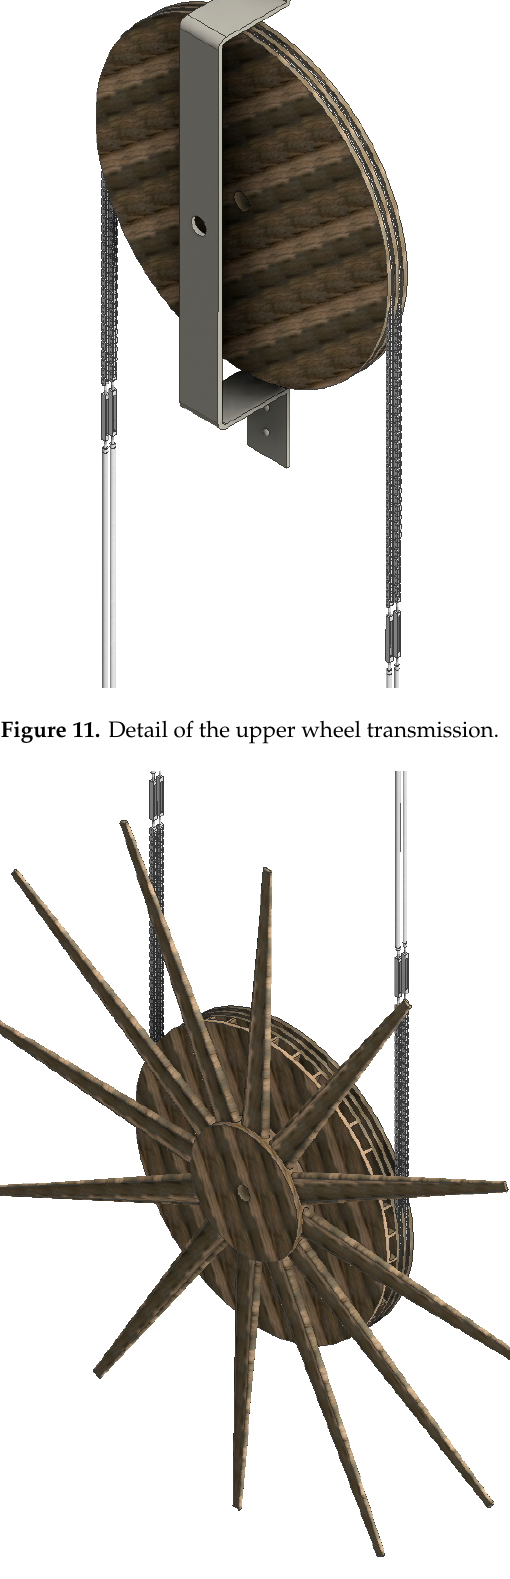
Figure 12. Detail of the transmission on the winch.